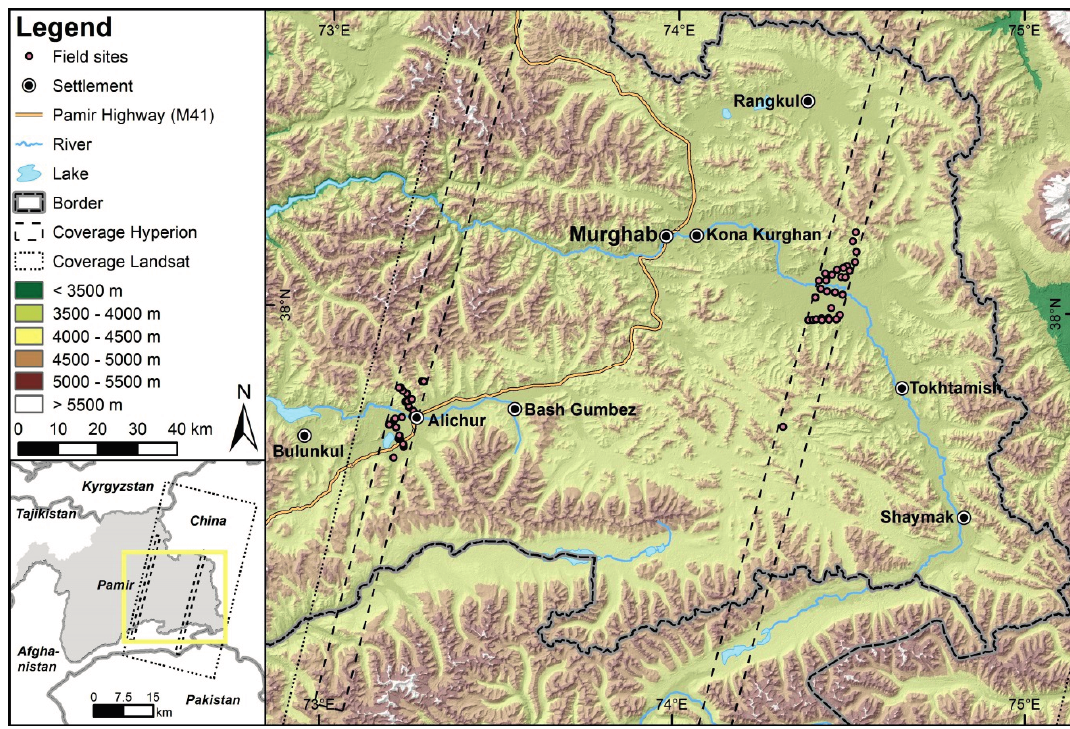
Figure 1. Overview of the research area, analyzed satellite images and field sites. The two Hyperion scenes were acquired on 3 August 2012 (western scene) and on 29 July 2013 (eastern scene), the Landsat OLI scene on 28 July 2013 respectively. DEM source: METI & NASA